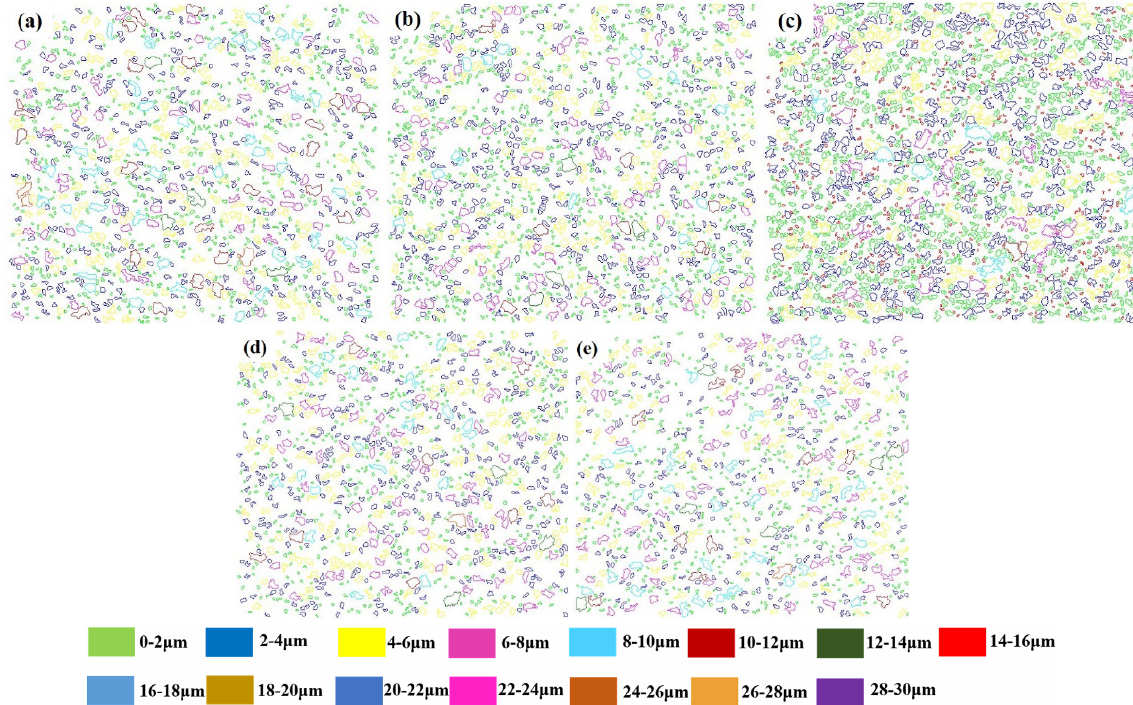
Fig. 6 Photographs of extracted pore boundary of specimens: (a) C220, (b) C330, (c) C774, (d) C330-774, and (e)